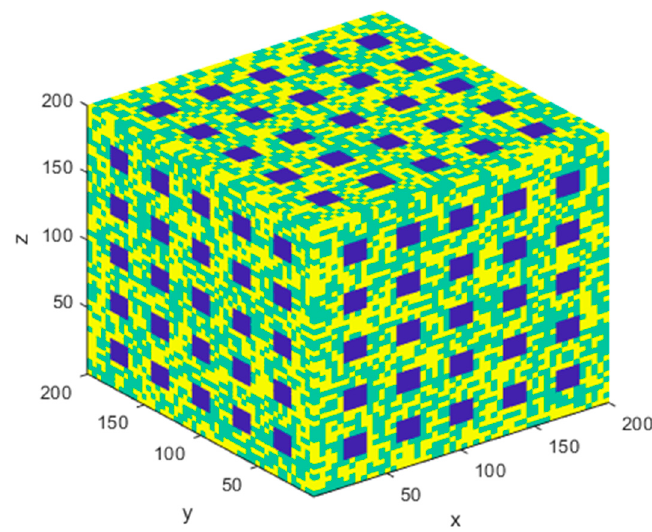
Figure 3. The previous heterogeneous model, penetrated with straight channels of water, all aligned with the numerical grid (200 × 200 × 200 cells).